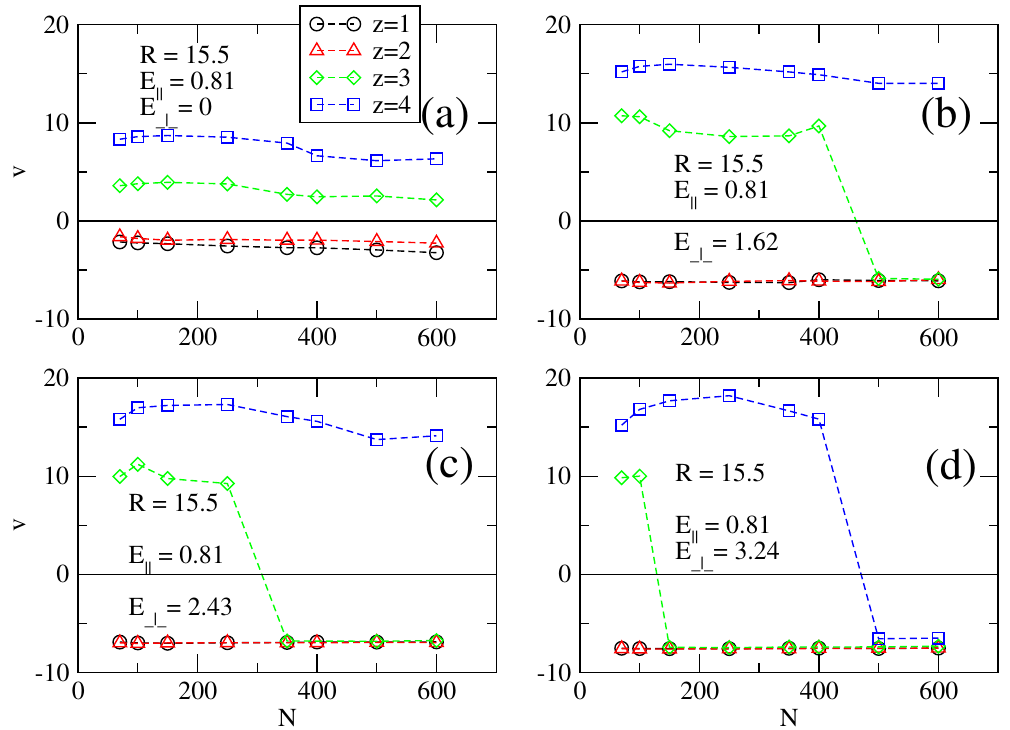
Figure 4. Graphs similar to Figures 2 and 3 for cylinder radius of R = 15 . 5 .